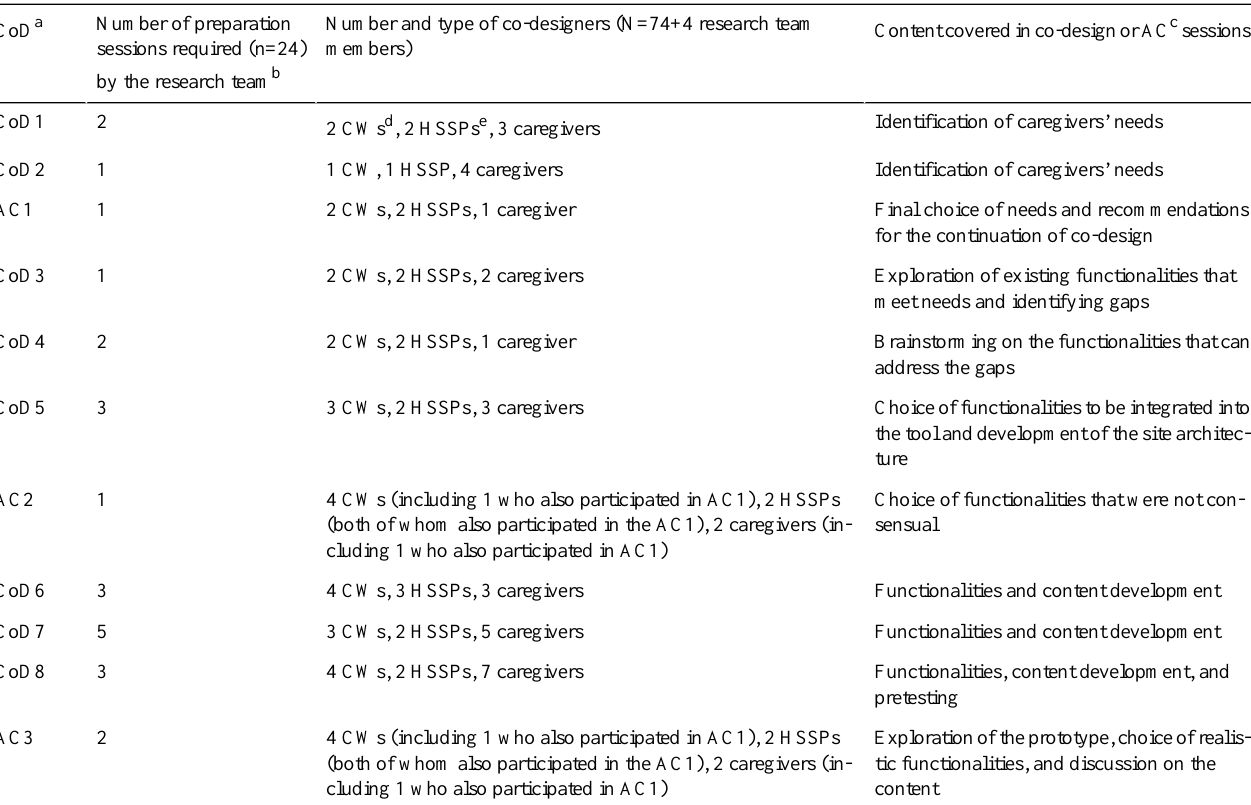
Table 1. Number of preparation sessions required for the research team, the number and type of co-designers at each co-design sessions, and the content covered in co-design